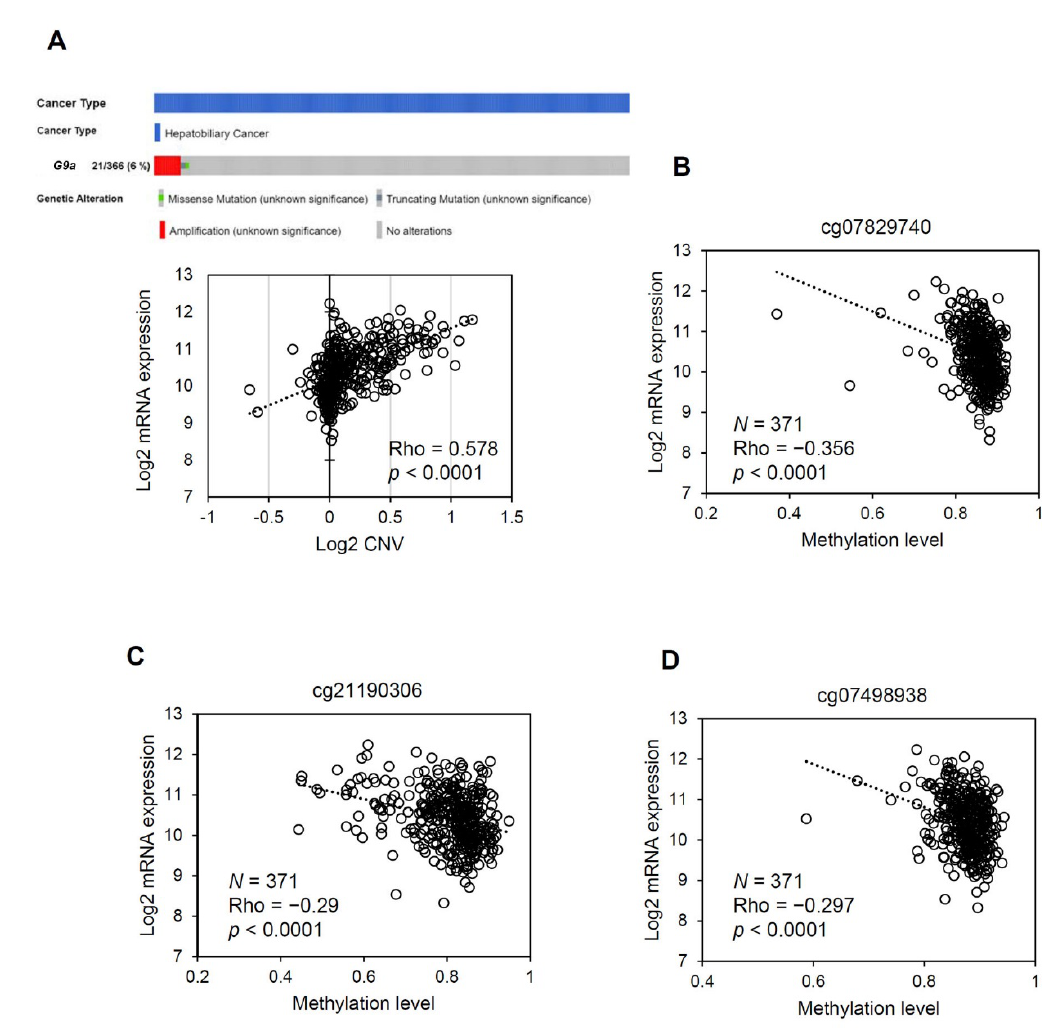
Figure 4. G9a expression is controlled at both the genetic and epigenetic levels. ( A ) Upper panel: OncoPrint of G9a gene alterations in TCGA HCC dataset obtained from the cBio Cancer Genomics Portal (http://cbioportal.org, accessed date: 25 January 2020). Lower panel: Copy number variants (CNVs) affect G9a gene expression. Positive and negative values re- spectively indicate gain and loss of the copy number. ( B – D ) Correlations of indicated CpG sites and G9a mRNA expression from TCGA HCC dataset ( n = 371). Correlations were analyzed using the Spearman rank method. Regression lines, Spear- man’s rho, and p -values are shown on the plot. Data used for correlation analyses were obtained via the Xena platform (https://xena.ucsc.edu/cite-us/, accessed date: 25 January 2020).